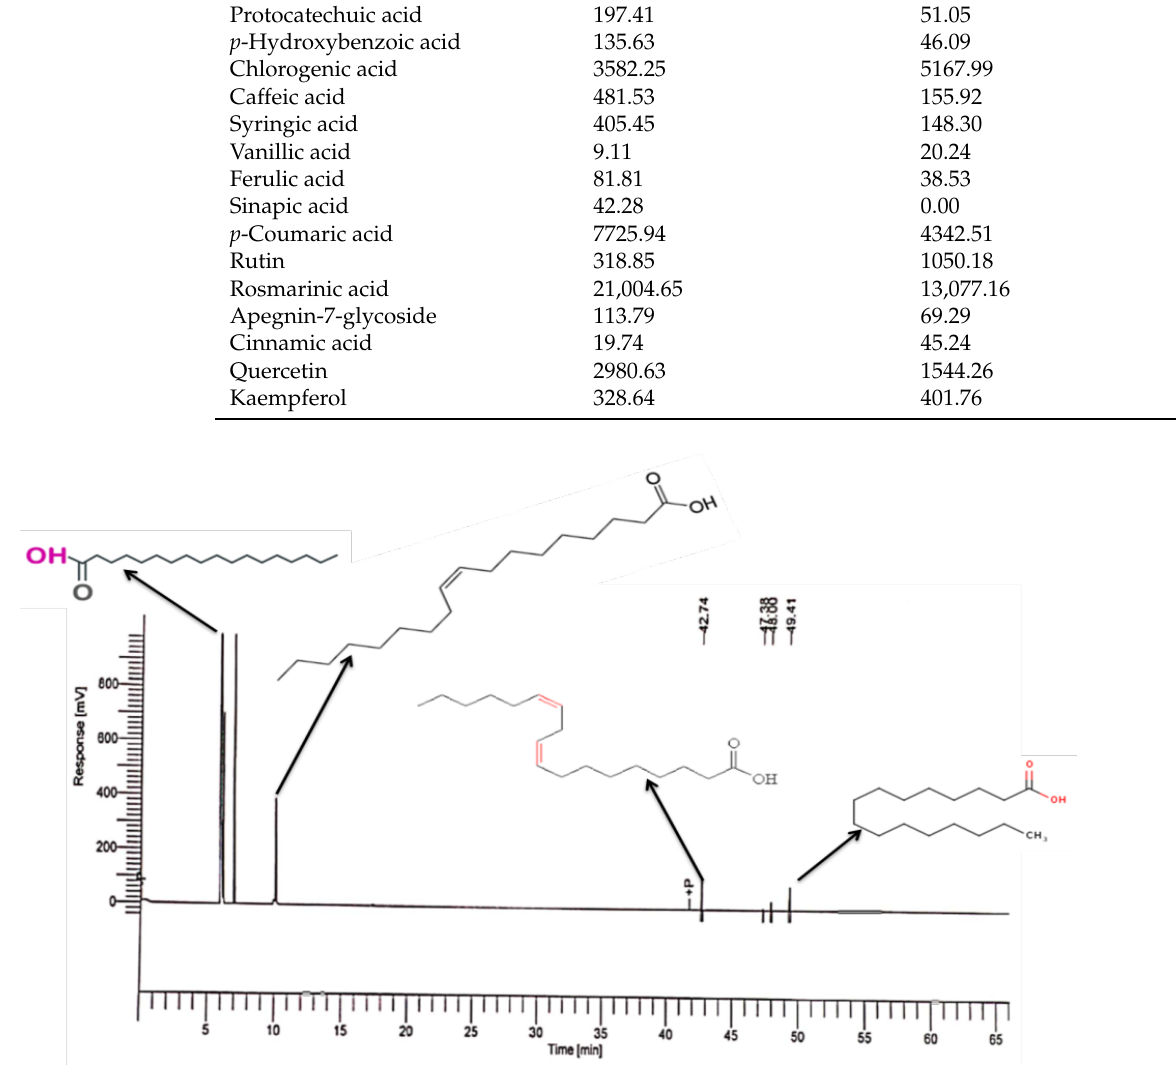
Figure 6. GC-MS analysis of Echinops spinosissimus hexane extract.